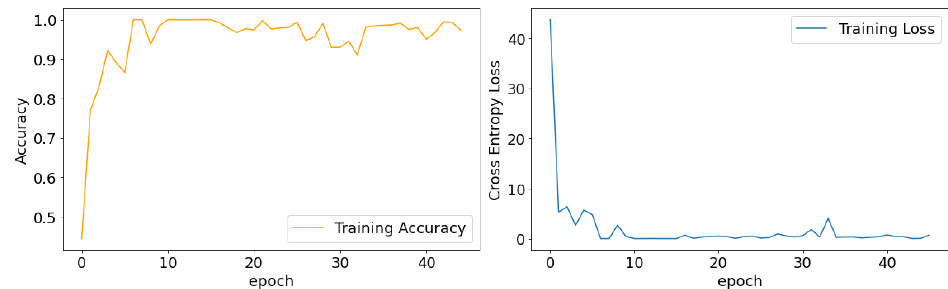
Figure 2. The training accuracy and training loss curves during the transfer learning